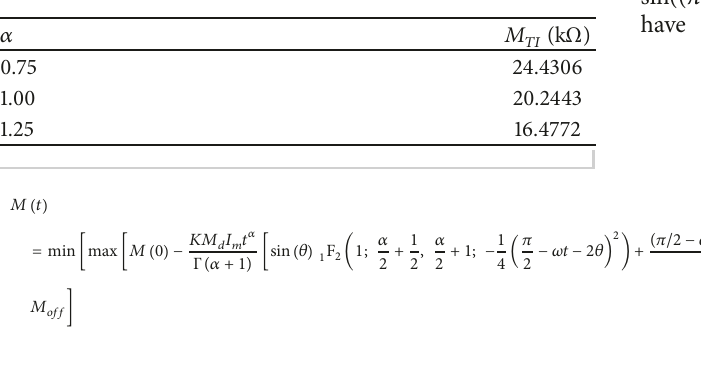
Table 2: 𝑀 𝑇𝐼 due to 𝐼 𝑀 < 0